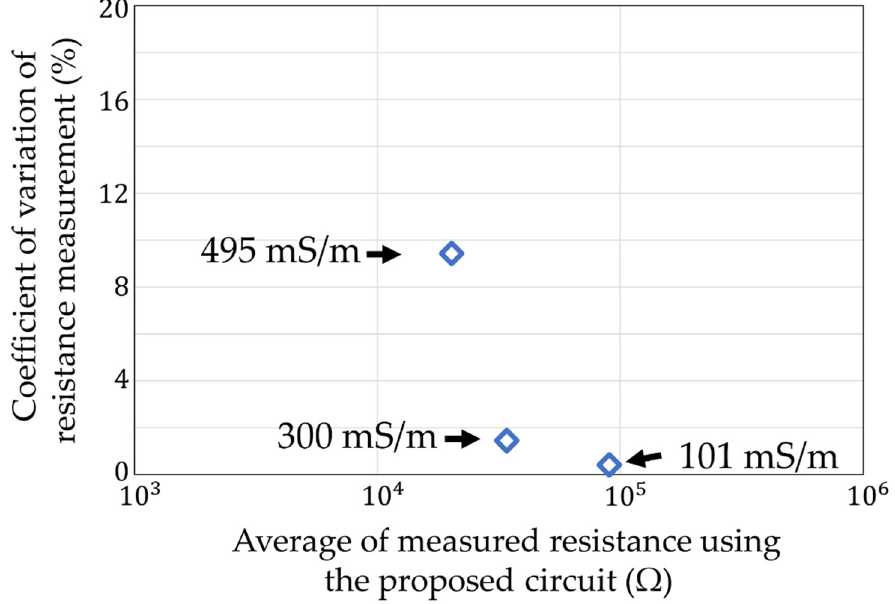
Figure 27. Coefficient of variation in Figure 25.